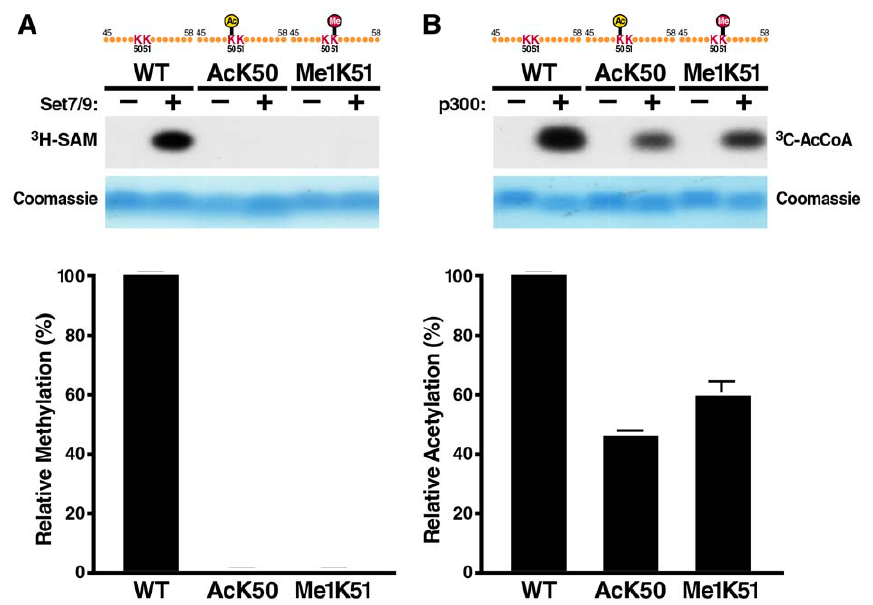
Figure 1. Invitro acetylation and methylation assays using synthetic Tat peptides. (A) In vitro methylation assays of Tat ARM peptides (aa 45–58). Unmodified, K50-acetylated or K51-methylated peptides were incubated with recombinant SET7/9/KMT7 and 3 H-radiolabeled S-adenosyl-L- methionine (SAM). Peptides were separated by Tris-Tricine gel electrophoresis and visualized by autoradiography. A quantification of band intensities of three independent experiments is shown below. (B) In vitro acetylation assays of Tat ARM peptides. Unmodified, K50-acetylated or K51-methylated peptides were incubated with recombinant p300-HAT and 14 C-acetyl coenzyme A. Peptides were processed as in A. A quantification of band intensities of three independent experiments is shown below.